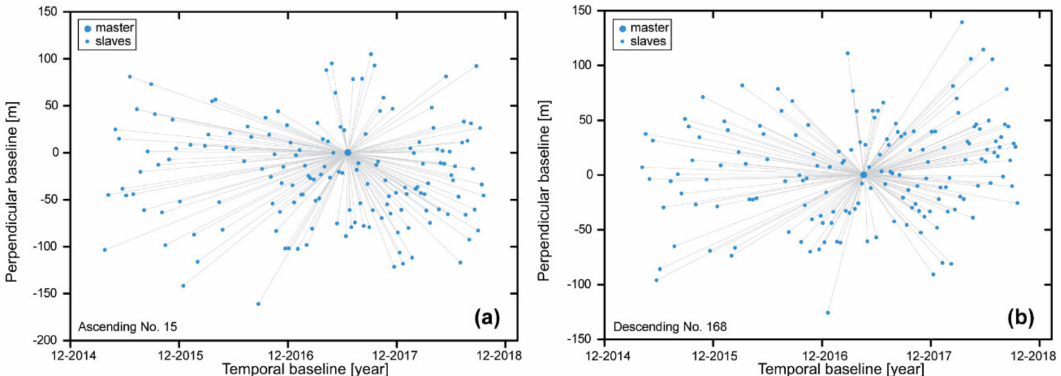
Figure 3. Sentinel-1 images graphs (single master PS analysis) for the Ascending frame no. 15 ( a ) and the Descending frame no. 168 ( b ). Each point represents an image and each line represents an interferogram. x -axis: temporal baseline of the acquisitions. y -axis: normal baseline of the acquisitions. A strong preliminary network consisting of a sub-selection of PSC (ASI> 0.8) was created to estimate the height and velocity parameters to detect and remove the atmospheric phase screen